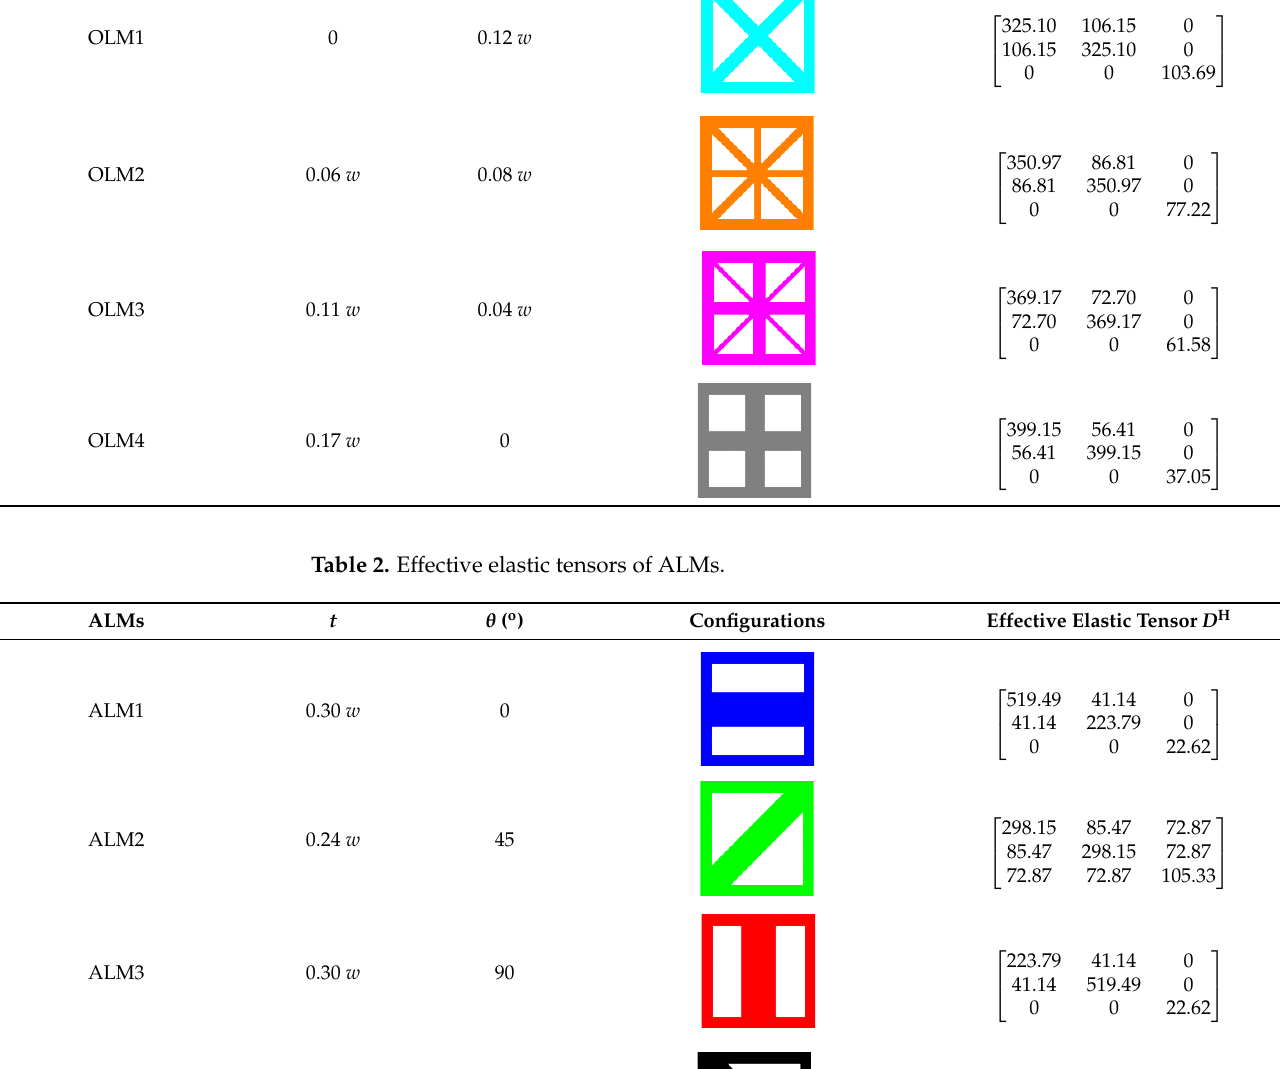
Figure 1. Lattice microstructures with geometric parameters: ( a ) OLM; ( b ) ALM. Table 1. Effective elastic tensors of OLMs.